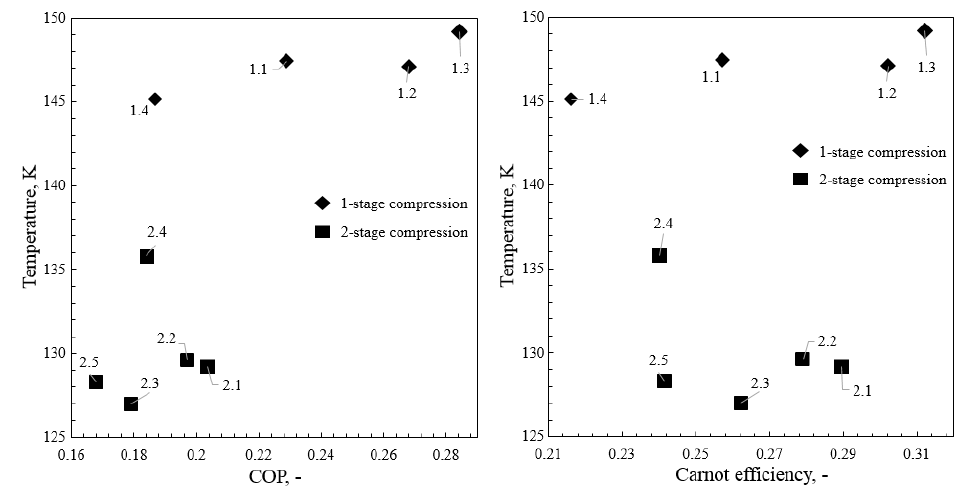
Figure 7. The performances of the analyzed refrigerant configurations.